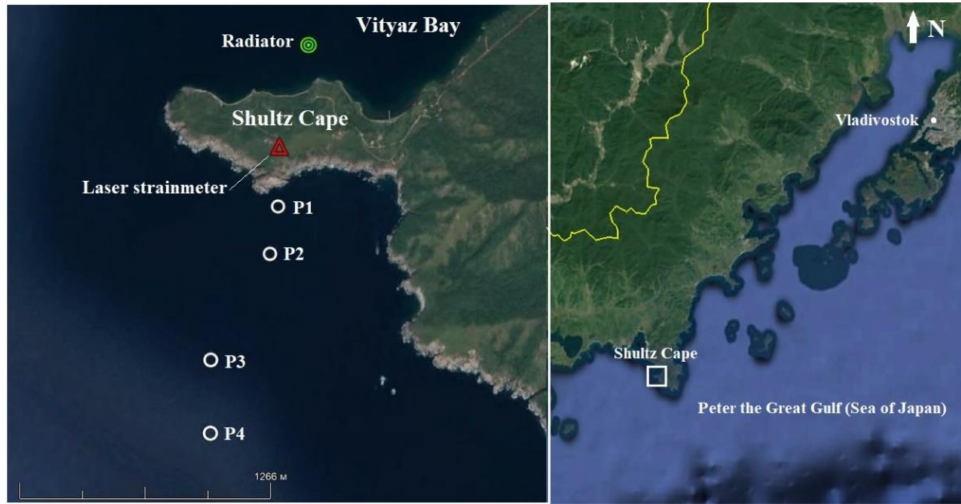
Figure 1. Scheme map of the experiment. The “radiator” was the transmitting point; P1 − P5 were measurement